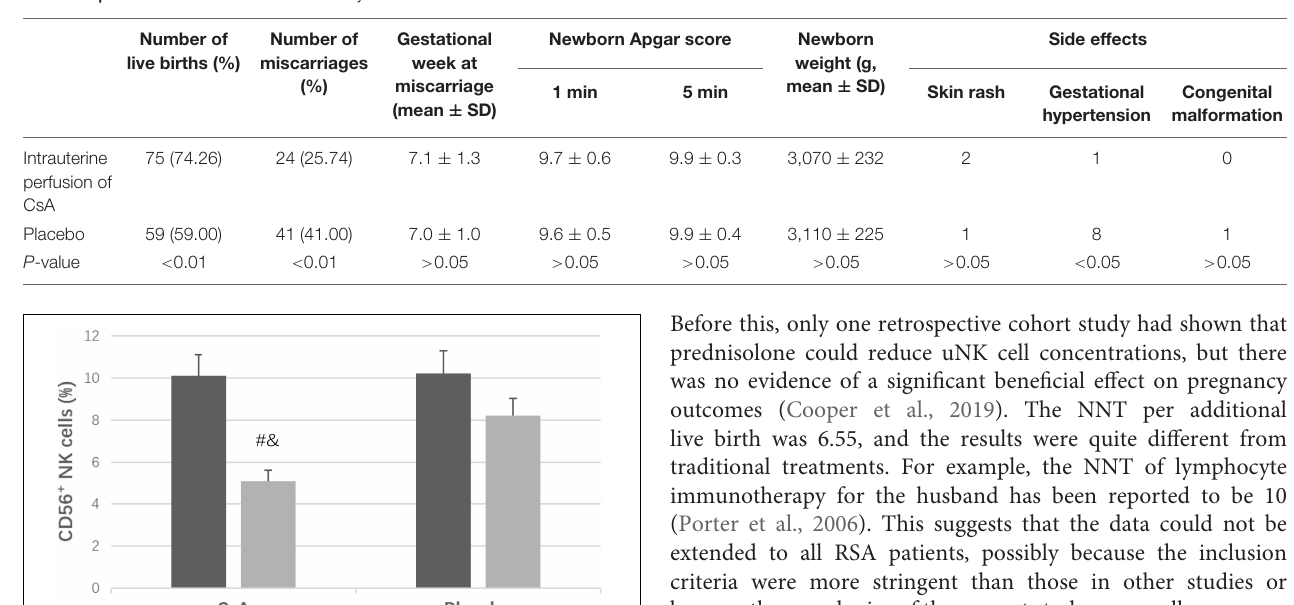
TABLE 2 | The main outcome and secondary outcomes.